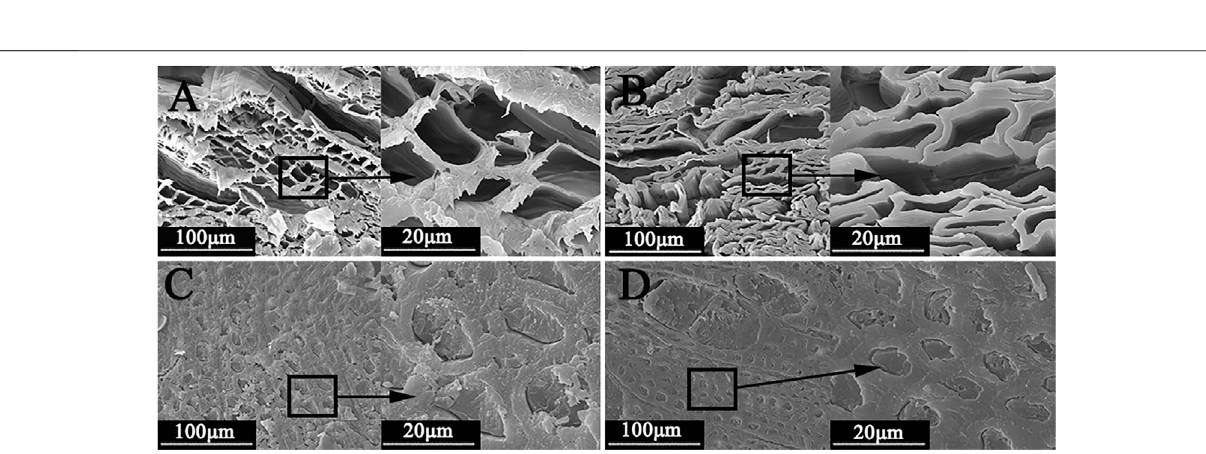
Frontiers in Materials |